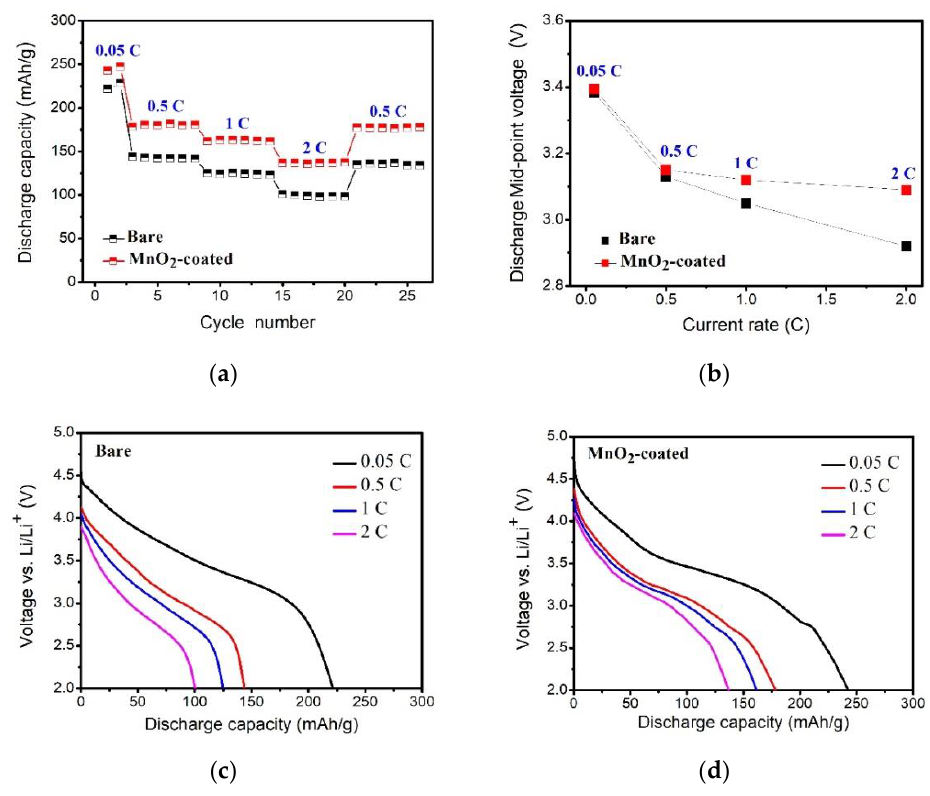
Figure 7. The electrochemical properties of the bare and MnO 2 -coated LTMO evaluated at various C rates. ( a ) The rate capabilities. ( b ) The discharge midpoint voltage. ( c , d ) Discharge curves.